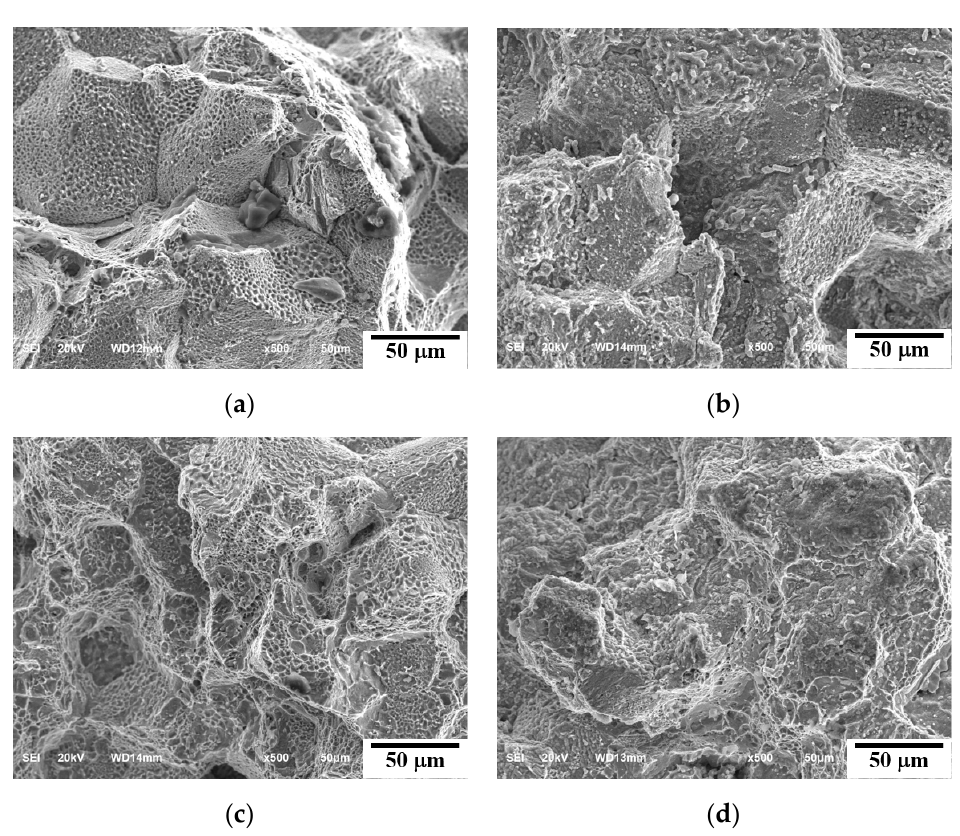
Figure 3. SEM micrographs of crept fractures: ( a ) 750 °C/150 MPa/222 h, ( b ) 750 °C/110 MPa/925 h, ( c ) 750 °C/90 MPa/2310 h, and ( d ) 750 °C/70 MPa/4680 h.